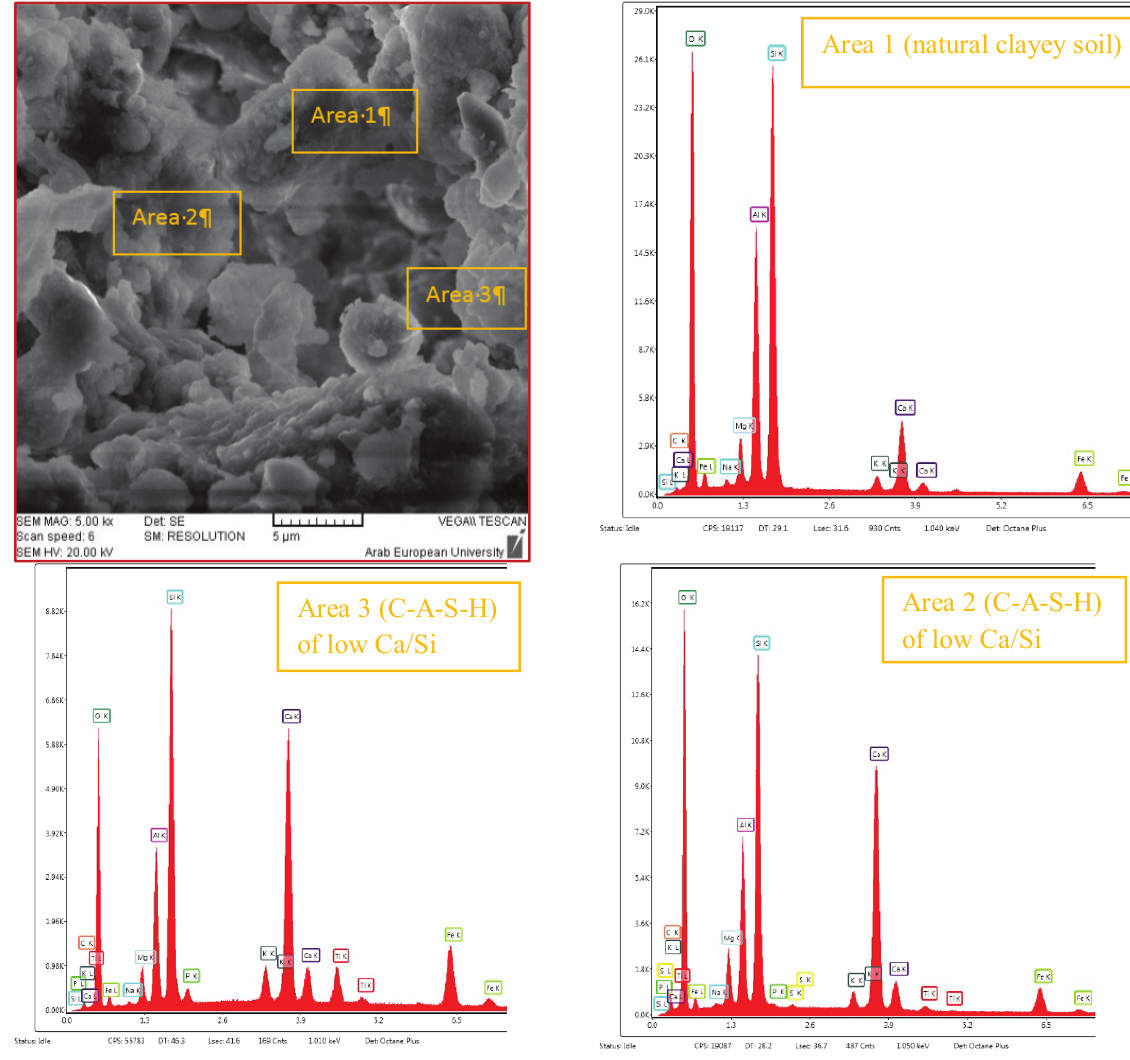
Figure 10. SEM micrograph and EDX analysis of CC20L0 mixture (soil 2) cured for 7 days. Figure 10: SEM micrograph and EDX analysis of CC20L0 mixture (soil 2) cured for 7